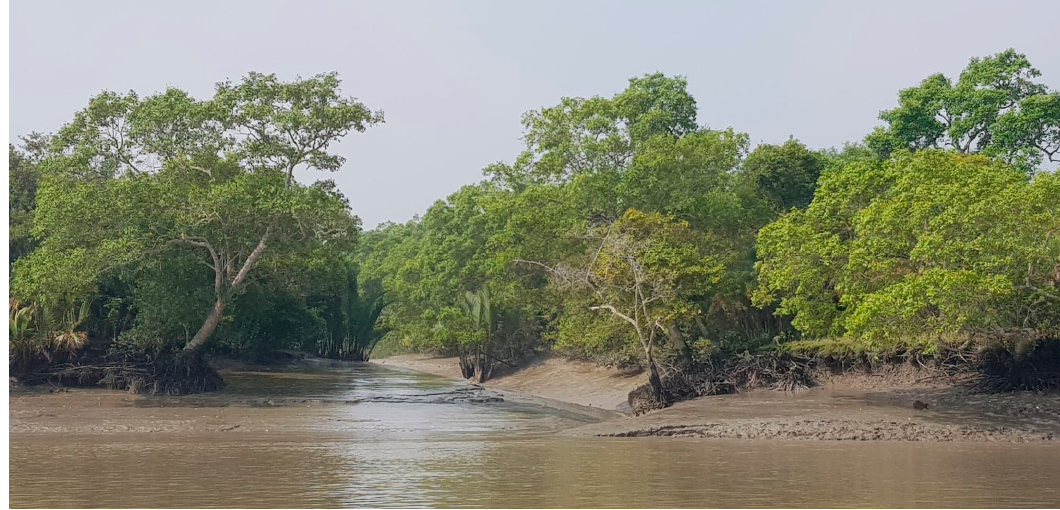
Figure 1. Image of the mangrove forest, the Sundarbans. Source: Author’s fieldwork (February 2018–March